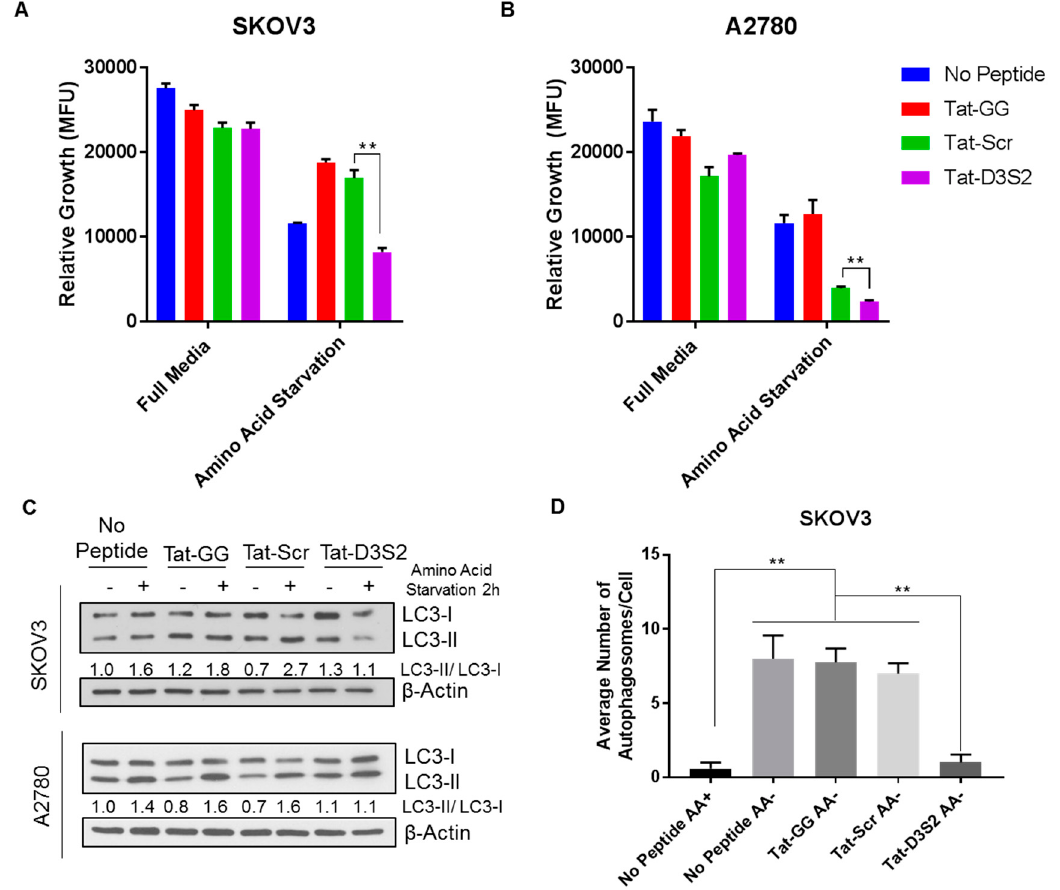
Figure 5. Cont . Figure 5.